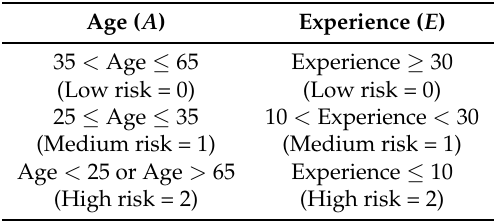
Table 2. Driver’s attitude parameters and risk